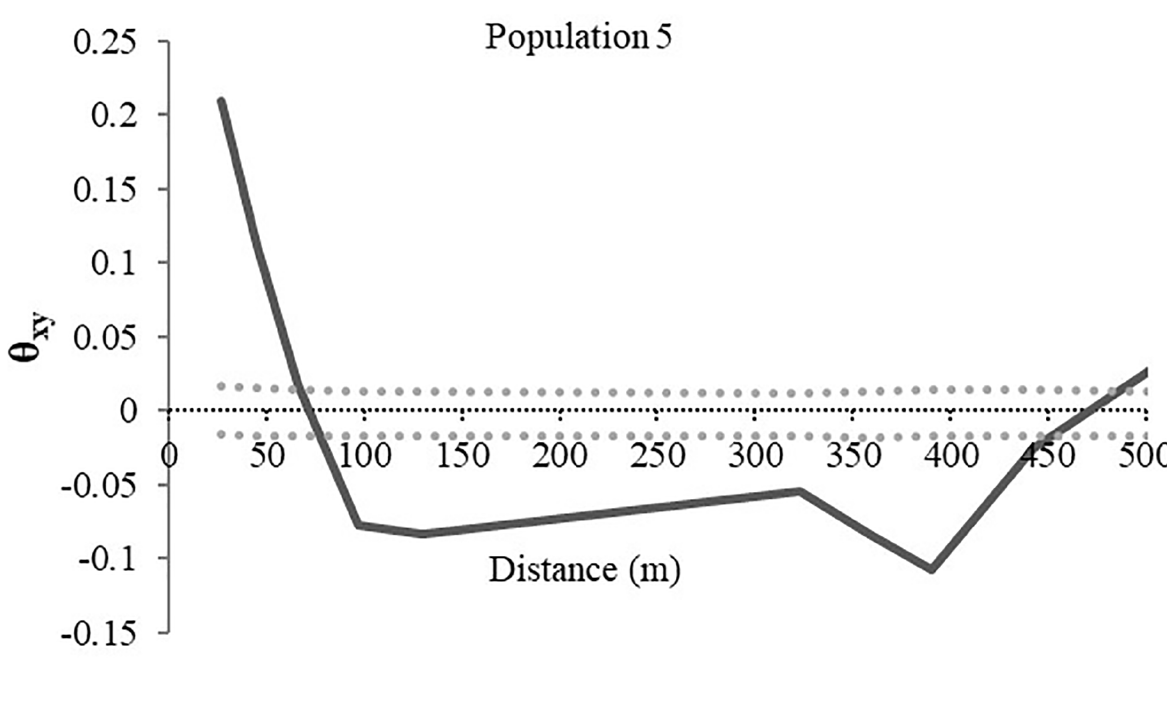
Figure 6. Graphical representation of the coancestry coefficient. Dashed lines correspond to the 95% confidence interval, and solid line shows the coancestry coefficient in the population of Guadua aff. lynnclarkiae